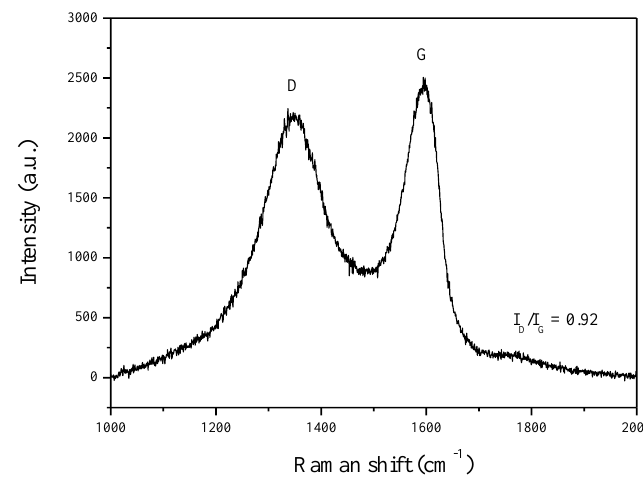
Figure 4. Raman spectrum of graphene oxide (GO).